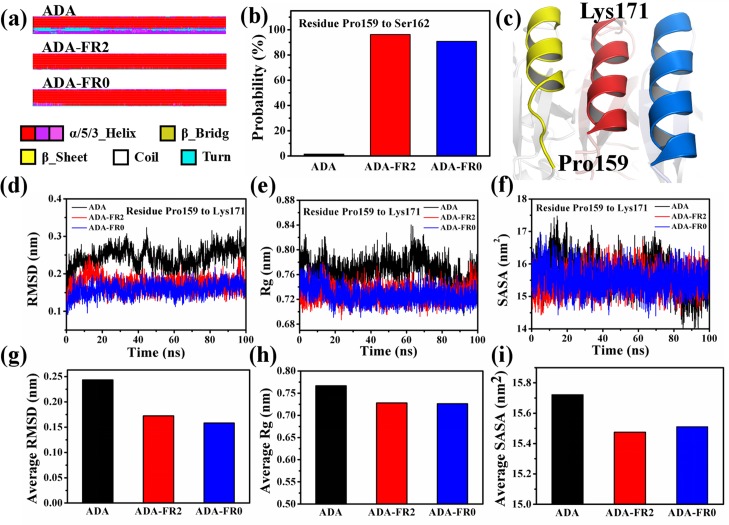
Conformation change in residues P159 to K171 of the three systems: ADA, ADA-FR2, and ADA-FR0.(a) Differences in the secondary structures of residues P150 to K171 of the three systems. (b) Probability of P159 to S162 to form a helix. (c) Structure of P159 to K171 (yellow for ADA, red for ADA-FR2, and blue for ADA-FR0). (d) RMSD; (e) Rg; and (f) SASA of P159 to K171 in the 100 ns simulations. (g) Average RMSD; (h) average Rg; and (i) average SASA of P159 to K171.